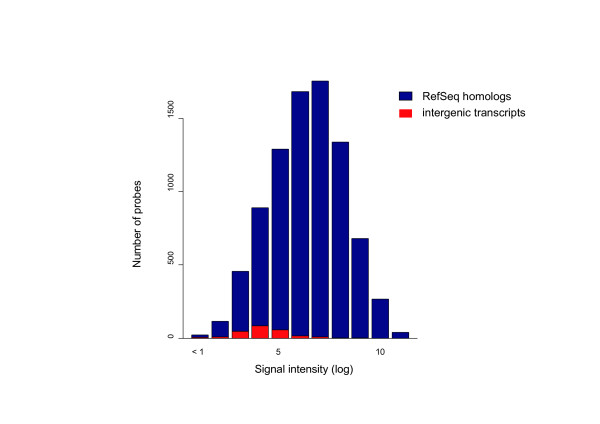
Distribution of transcript expression levels of the RefSeq homologs (blue) and the intergenic transcripts (red). Only the transcripts that were determined as significantly expressed on the microarray are presented in the figure. Log-transformed signal intensity in the tissue with the highest expression was shown. The intergenic transcripts showed significantly lower expression levels than the RefSeq homologs.